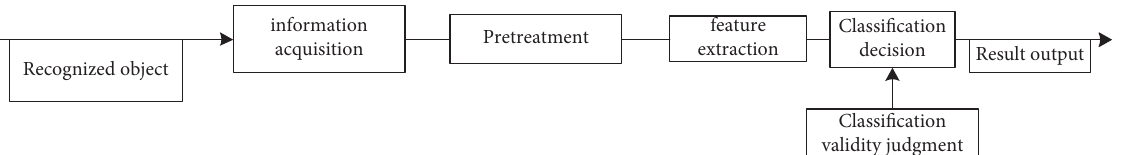
Figure 1: Structural block diagram of pattern recognition